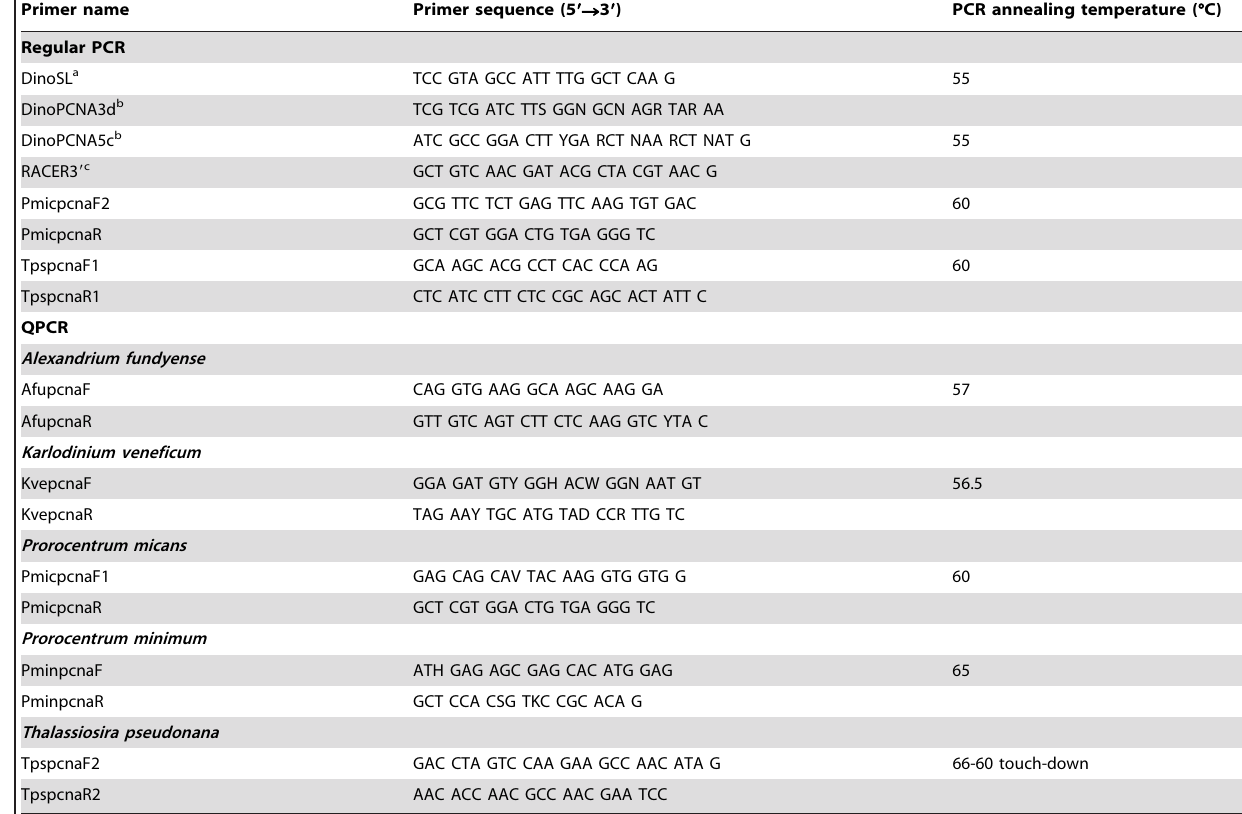
Table 1. PCR primers used in this